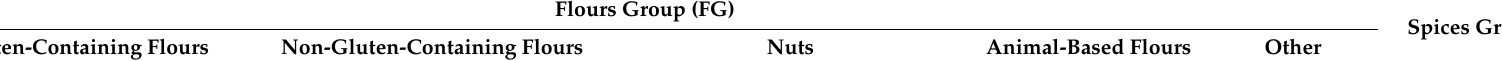
Table 1. Materials measured by the near-infrared (NIR)